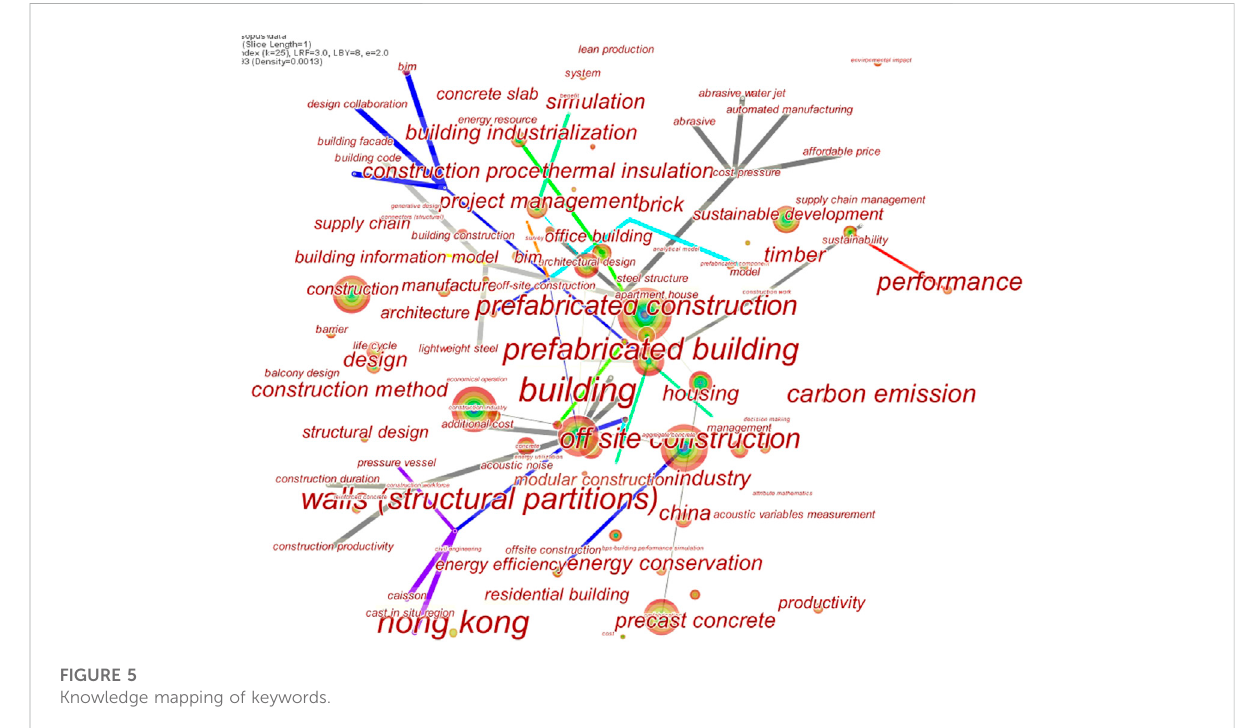
FIGURE 5 Knowledge mapping of keywords.